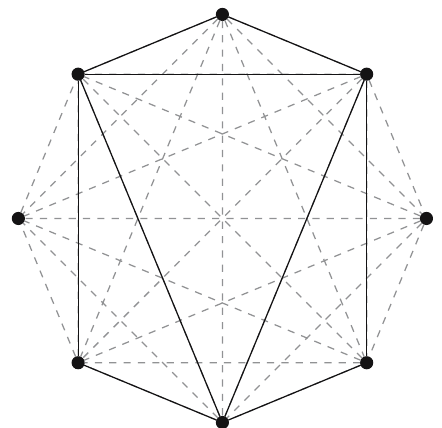
Figure 2: The signed graph K σ , 8 ( ) of Example